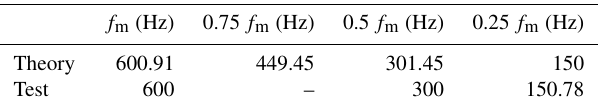
Table 6. Frequency multiplication response of the gearbox at n =